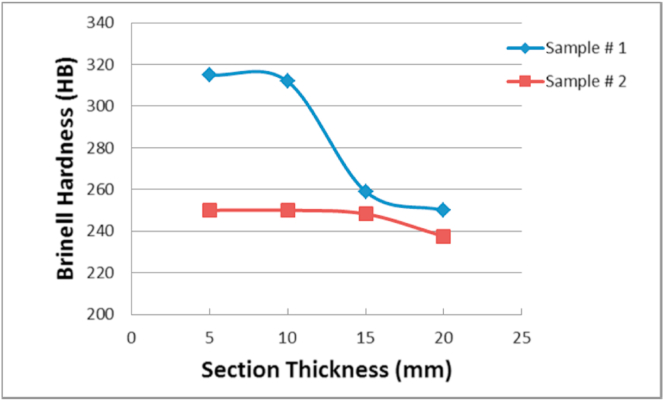
Brinell hardness vs. section thicknesses in mm.